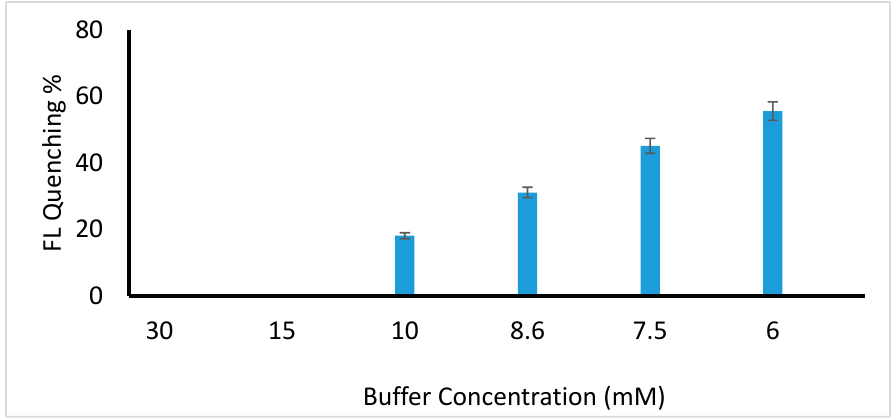
Figure 3. Effect of concentration of buffer on QDs fluorescence quenching by verapamil HCl.